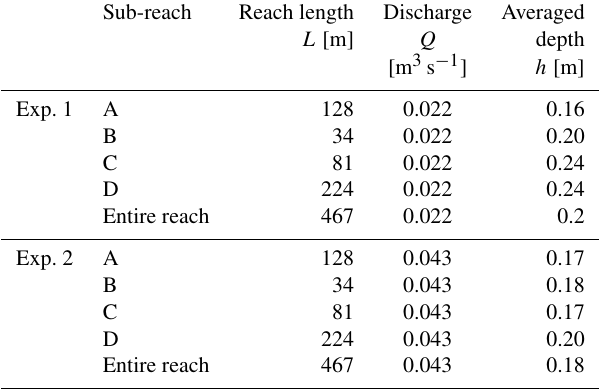
Table 1. Main properties of the four sub-reaches and the entire anal- ysed reach of the channel during the experiments with (Exp. 1) and without (Exp. 2) vegetation.